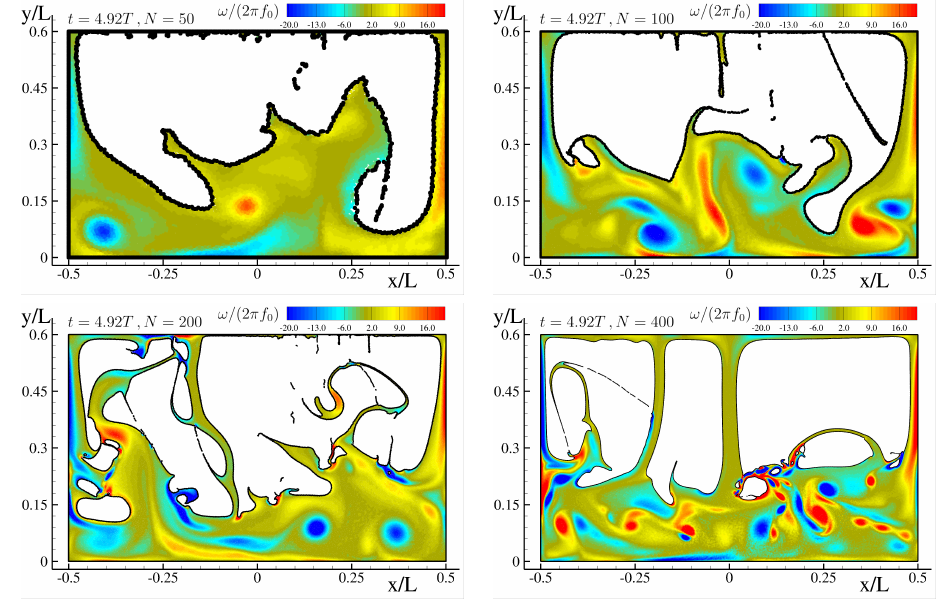
Figure 8. Test with oil: vorticity fields at the fourth bottom impact for different spatial resolutions N = 50, 100, 200,